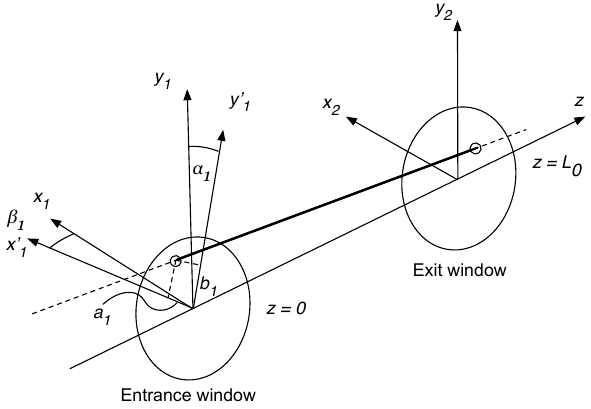
Figure A1. Geometry for the calculation of the absorption length. Two arbitrarily oriented spherical windows are located at a distance L 0 along the z axis. Unprimed axes designate coordinates in the lab- oratory frame, and primed axes apply to coordinates on the window surfaces. Euler angles α 1 , β 1 define the window orientation. The light beam, indicated by a bold line between the windows, passes ) = (a 1 ,b 1 ) on the through the entrance window at point (x (cid:48) , y (cid:48) 1 1 outer surface. The window thickness is ignored in the